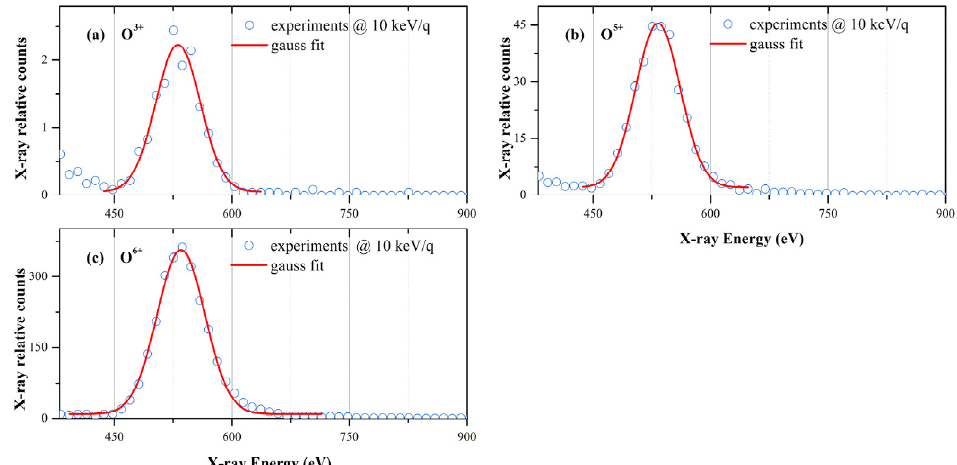
Figure 2. The X-ray spectra in the interaction of O q+ (q = 3, 5, 6) ions with the Cu surface at kinetic energy of 10 keV/q: ( a ) O 3+ , ( b ) O 5+ , ( c ) O 6+ .